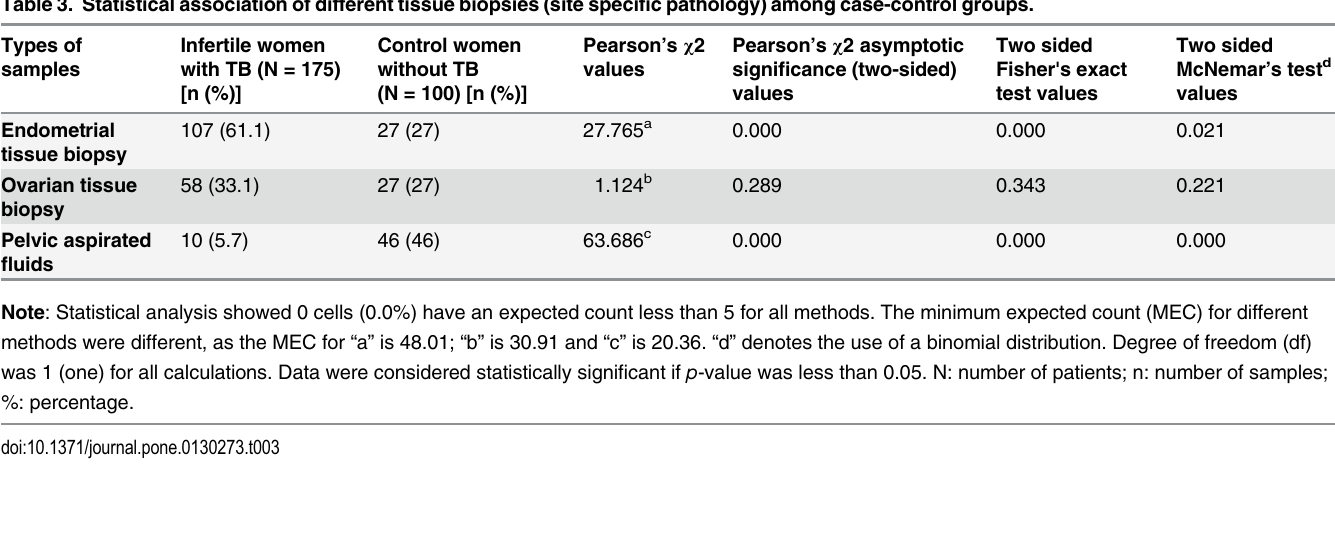
Table 3 partly explains the statistical association of different tissue biopsies (site specific pathology) among case-control groups. Of the 175 FGTB patients, majority of them (76.6%) presented primary infertility, 41 (23.4%) with secondary infertility (Fig 4) and 59 (33.7%) women experienced abortion. Apart from infertility, 109 (62.3%) patients had other menstrual complaints such as dys- menorrhoea in 84 (48%) women and abdominal/ pelvic pain in 25 (14.3%) women. Fifty two (29.7%) patients had menstrual irregularities such as oligomenorrhea (10.9%), amenorrhea (9.1%), general malaise (5.1%) and menorrhagia (4.6%) among infertile women. Forty four (25.14%) women were found to be without dyspareunia and dysmenorrhoea. Table 4 elucidates a greater frequency of menstrual complaints among infertile women with FGTB and HCW without TB. The statistical difference was significant, specified with Pearson ’ s χ 2 value = 5.338, 1 df, Fisher ’ s exact test value < 0.021 and χ 2 value = 0.021, McNemar ’ s test value < 0.0001. All FGTB patients were negative for chest X-ray and 40 (22.9%) patients were positive for Mantoux test. ESR was elevated in all FGTB patients, which showed the reading between 56 and 156. All the modalities of treatments such as ovarian induction, intra uterine injection, intra cytoplasmic sperm injection, in-vitro fertilization in 3 rd -4 th cycles and appro- priate surgical intrusions were unsuccessful to support fertility prior to anti-tubercular chemo- therapy. Favourable infertility outcomes following the anti-tubercular chemotherapy was reported among FGTB cases [99]. Further, efforts were made to assess SNPs among infertile women with FGTB rather than the treatment. Laparoscopy usually detects macroscopic